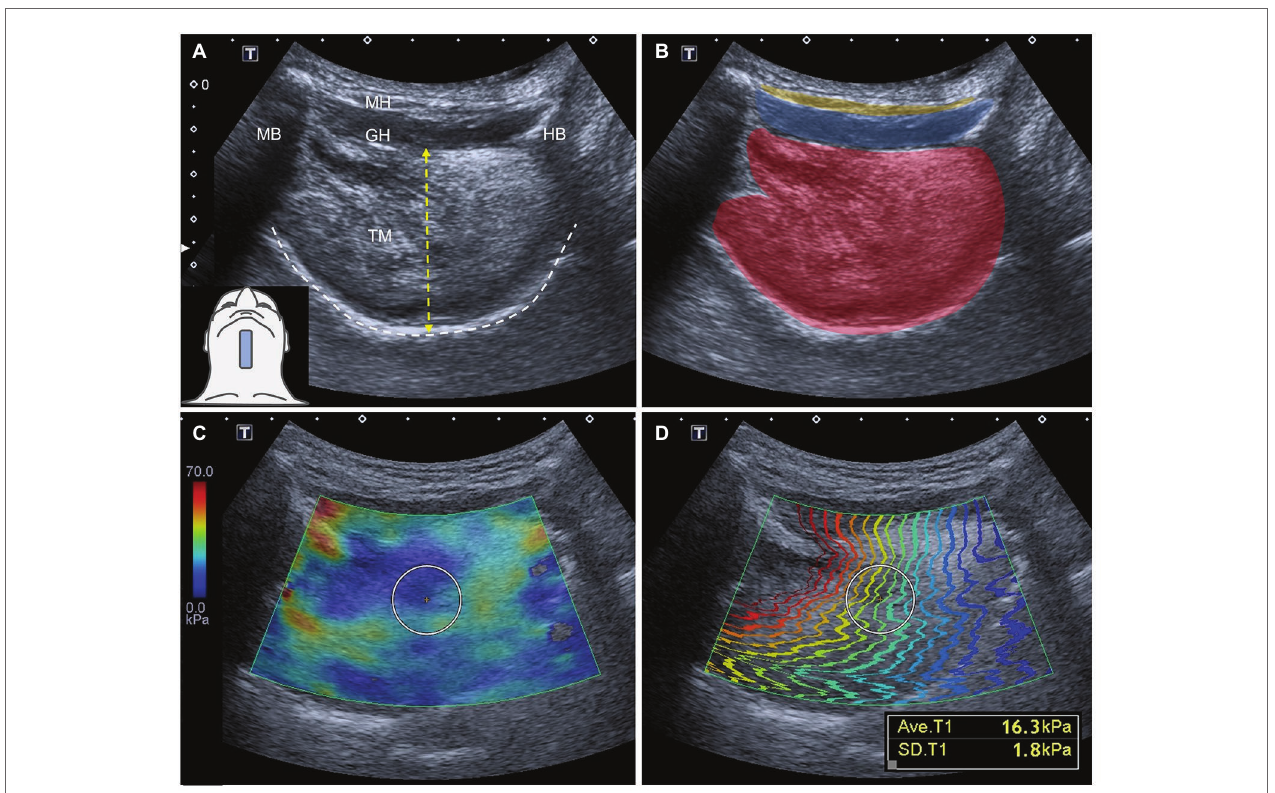
FIGURE 2 | Ultrasound imaging (A) and superimposed schematic drawing (B) of the tongue muscles in the sagittal plane. The white-dashed line indicates the dorsal surface of the tongue. The length of the yellow-dashed line indicates the thickness of the tongue. The color diagram (C) and propagation modes (D) of shear wave ultrasound elastography imaging for tongue muscles in the sagittal plane. The average shear modulus of the tongue in the selected region of interest is 16.3 kPa with a standard deviation of 1.8 kPa. TM: tongue muscles, red color block; MH: mylohyoid muscle, yellow color block; GH: geniohyoid muscle, blue color block; MB: mandible; and HB: hyoid